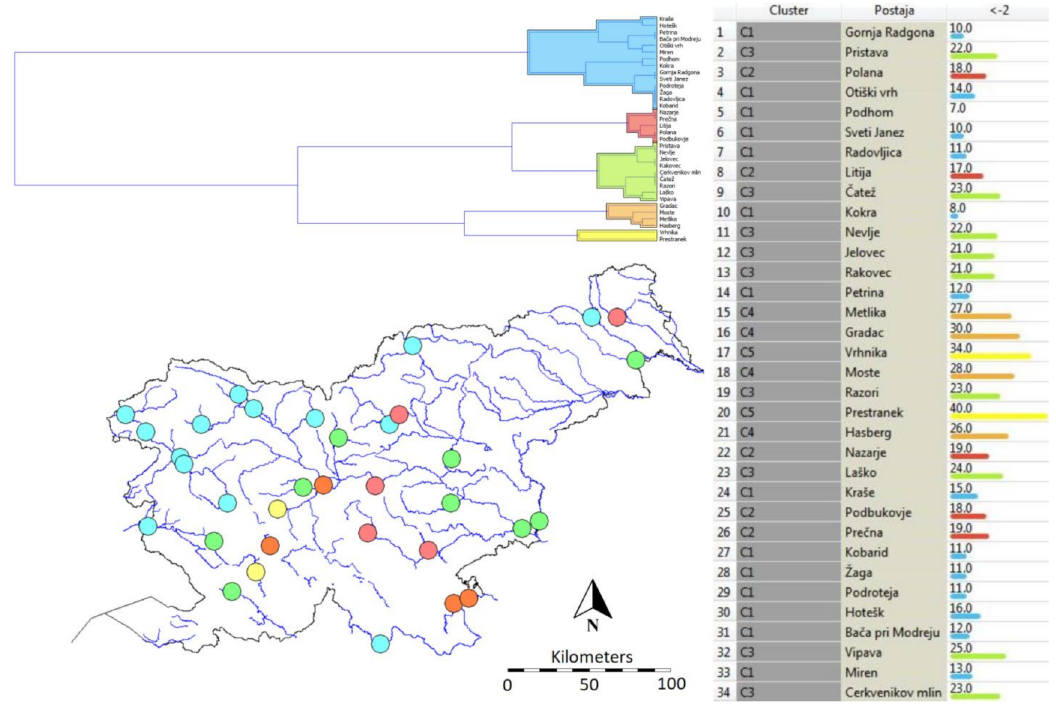
Figure 7. Hierarchical clustering of the number of extreme droughts using the six month time scale (SSI-6 < − 2) and spatial presentation of the results on the map of Slovenia. Groups are indicated by colours: C1 (blue), C2 (red), C3 (green), C4 (orange), and C5